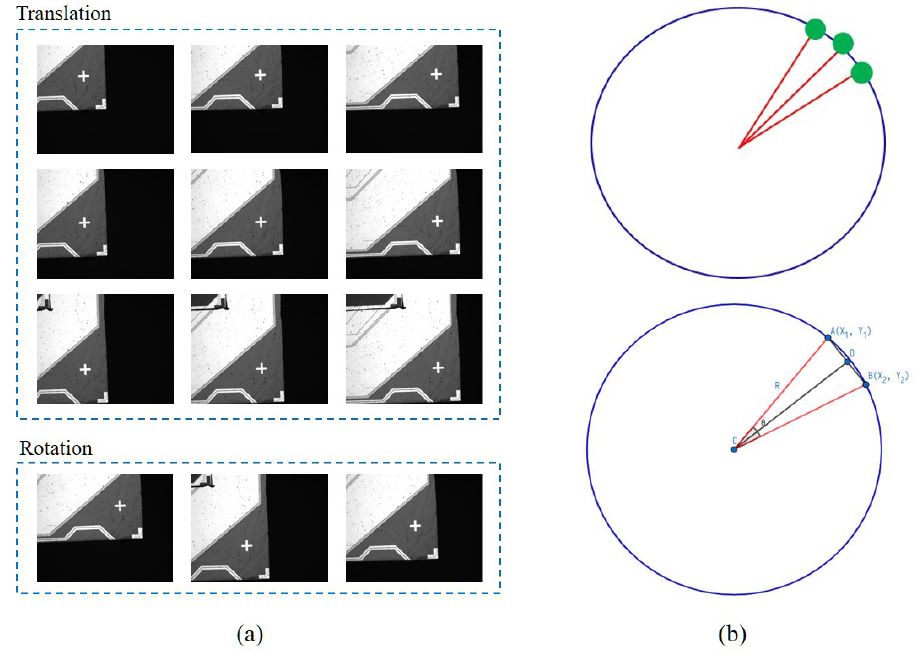
Figure 7. ( a ) Uses the 12-point misalignment correction method to determine the center of rotation and to calculate the offset of translation. These twelve sample images are taken by a pre-alignment camera installed above the carrier table; ( b ) calculates the physical rotation center on the occasion of a large radius and a small angular